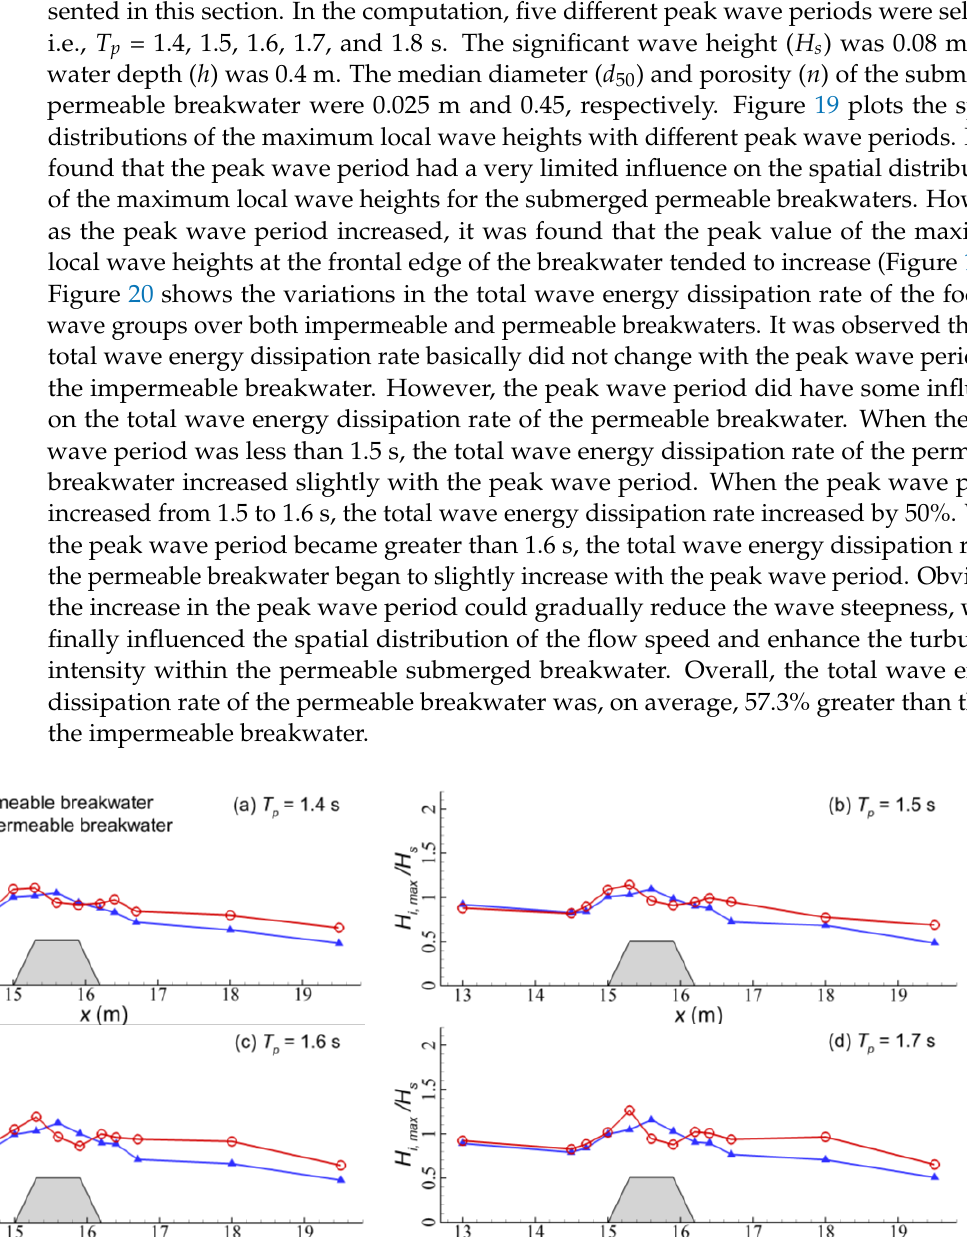
Figure 20. Variations in the total wave energy dissipation rate with the peak wave period. 5.5. Influences of the Porosity Influences of the porosity on the hydrodynamics of transformation processes of the focused wave groups over the submerged permeable breakwater are discussed in this section. Five different porosities were selected, i.e., 𝑛 = 0.35, 0.4, 0.45, 0.5, and 0.55. In the computation, the still water depth (ℎ) was 0.4 m. The significant wave height ( 𝐻 𝑠 ) was set to 0.08 m. The peak wave period was 1.6 s. Figure 21 shows the spatial distribution of the maximum local wave heights of the focused wave groups over the submerged breakwater with different porosities. It was found that the peak value of the maximum local wave heights gradually decreased with the porosity of the permeable medium. It was also found that the maximum local wave height of the focused wave groups behind the sub- merged permeable breakwater was much lower than that of the submerged impermeable breakwater, indicating that the submerged permeable breakwater had a better effect re- garding wave prevention. Figure 22 shows the variations in the total wave energy dissi- pation rate with the porosity of the permeable medium. Obviously, the total wave energy dissipation rate of focused wave groups monotonically increased with the porosity of the permeable medium since the increase in the porosity could greatly enhance the wave en- ergy dissipation caused by the turbulence violence within the submerged permeable breakwater. Furthermore, when the porosity of the permeable medium was between 0.4